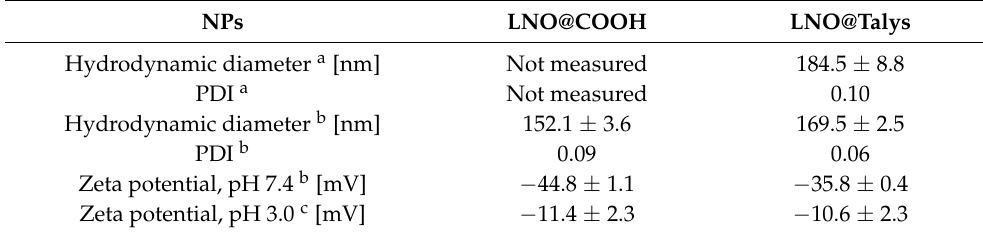
Table 2. DLS characterization of LNO@Talys NPs.